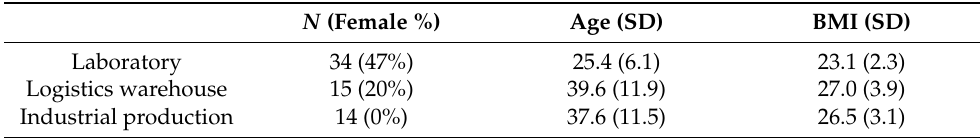
Table 1. Participants’ characteristics.